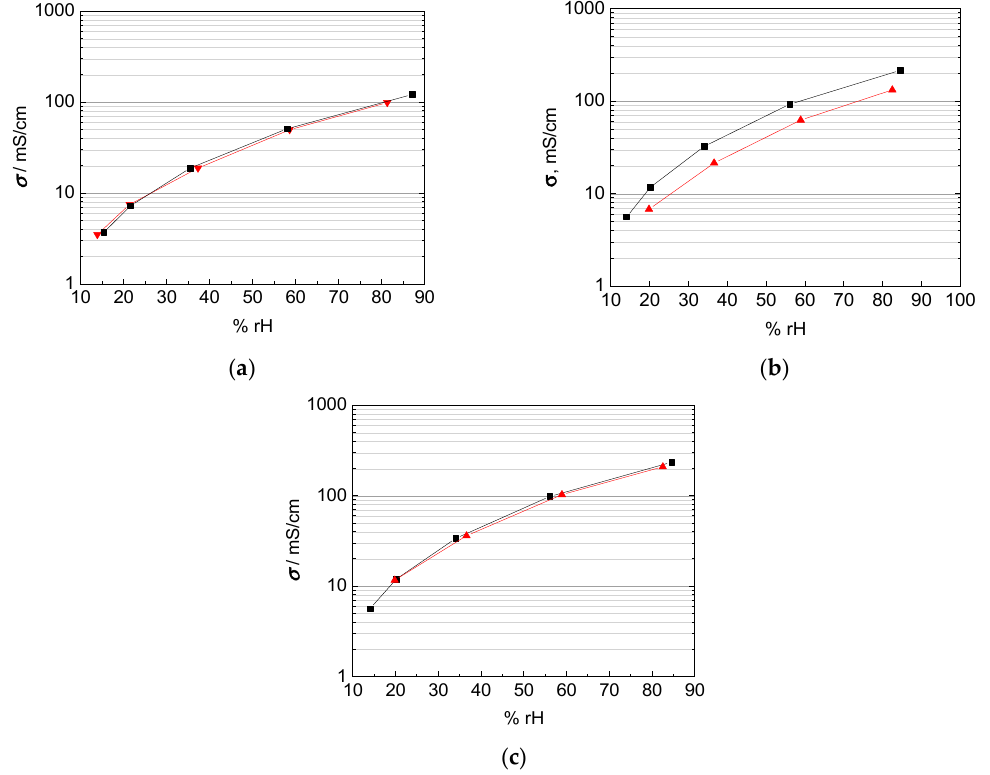
Figure 12. Comparison of in-plane (black) and through-plane (red) proton conductivity of ( a ) Nafion 117, ( b ) 3M 825 EW membrane with 100 µm thickness, and ( c ) 3M 825 EW membranes with 200 µm thickness.